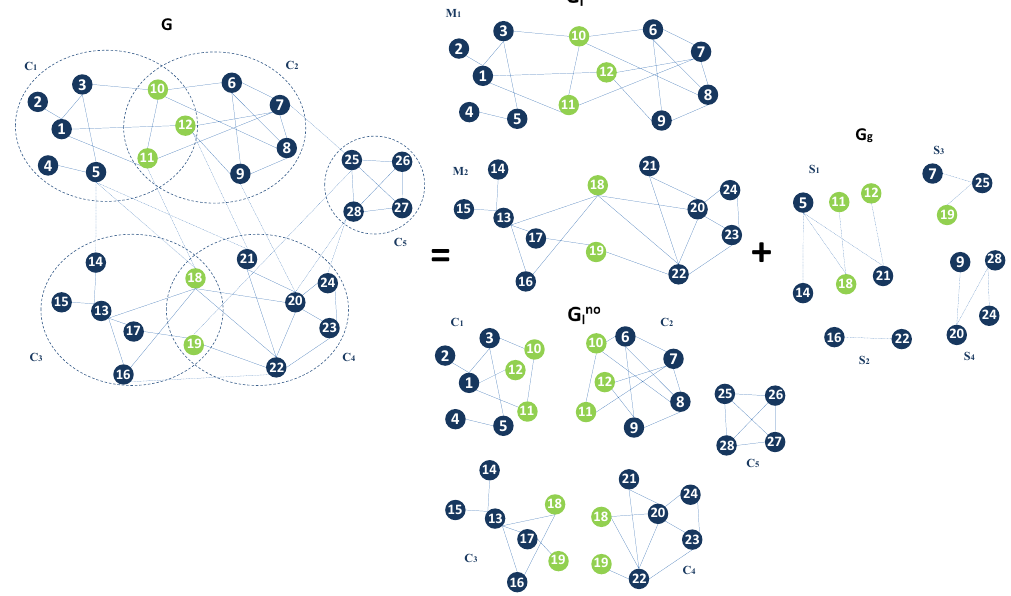
Figure 1. Toy example to illustrate how to form the local network for the non-overlapping nodes G ( ) lno , the local network for the overlapping nodes G (